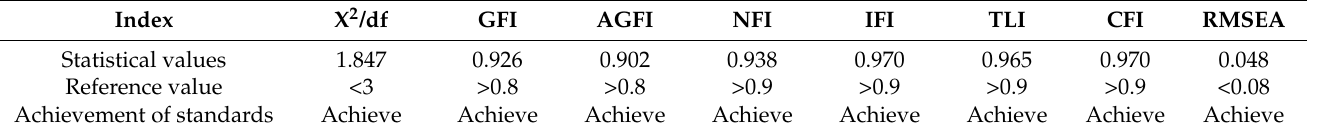
Table 8. Model fitting